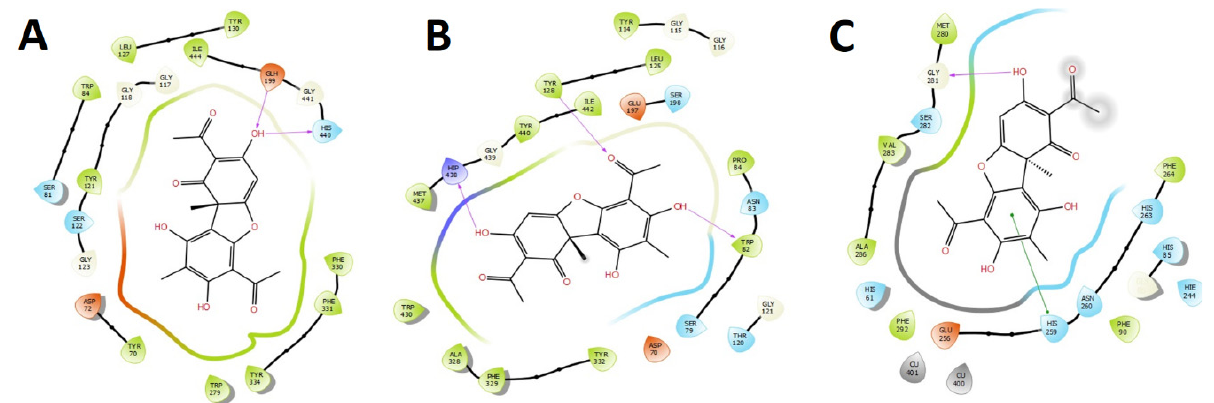
Figure 7. Two-dimensional diagram of ( A ) usnic acid in the acetylcholinesterase ( Tc AChE) catalytic site, ( B ) usnic acid in the butyrylcholinesterase ( h BuChE) catalytic site, and ( C ) usnic acid in the tyrosinase catalytic site. Magenta arrows represent hydrogen bond interactions; green lines represent T-shaped interaction. Orange amino acids indicate negative charged residues, magenta amino acids indicate positive charged residues, green amino acids indicate hydrophobic residues, and light blue amino acids indicate polar residues.